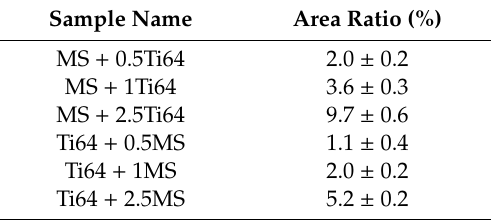
Table 3. Mean values and standard deviations of the calculated area ratio for all the samples.